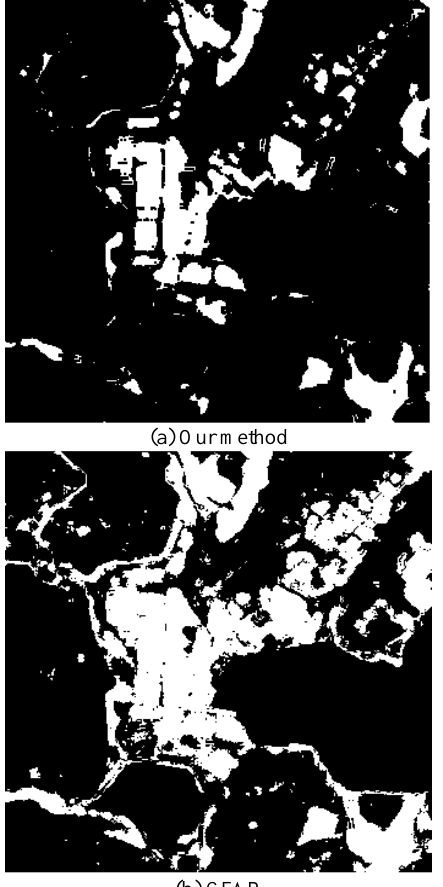
Figure 5. Change detection results of Our method on